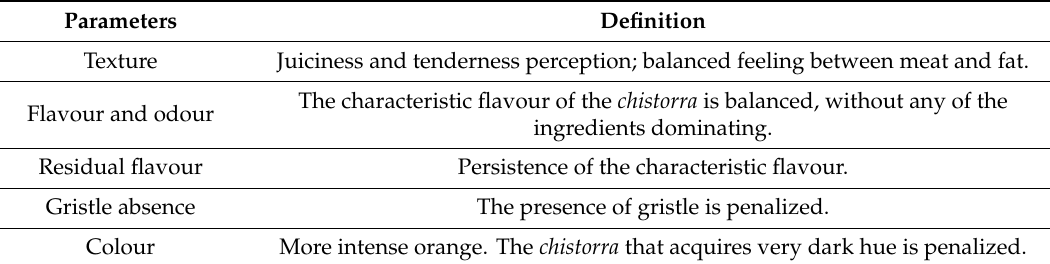
Table A2. Parameters evaluated on the cooked product at step 2 and step 3 of the